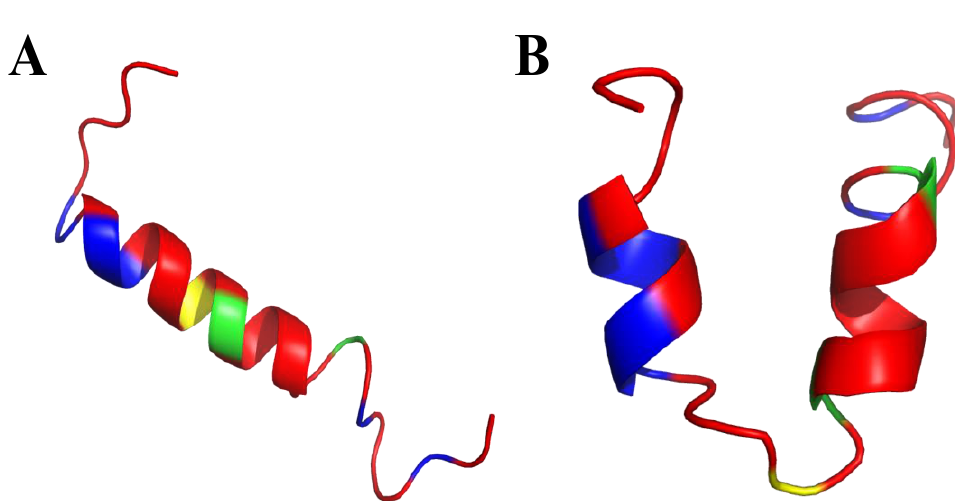
Figure 6. I-Tasser prediction of MgtR secondary structure. ( A ) one alpha-helix motif in the middle of MgtR secondary structure. ( B ) two short alpha-helix motifs in the middle of MgtR secondary structure. Amino acids are colored in red (hydrophobic), blue (hydrophilic), green (positively charged) and yellow